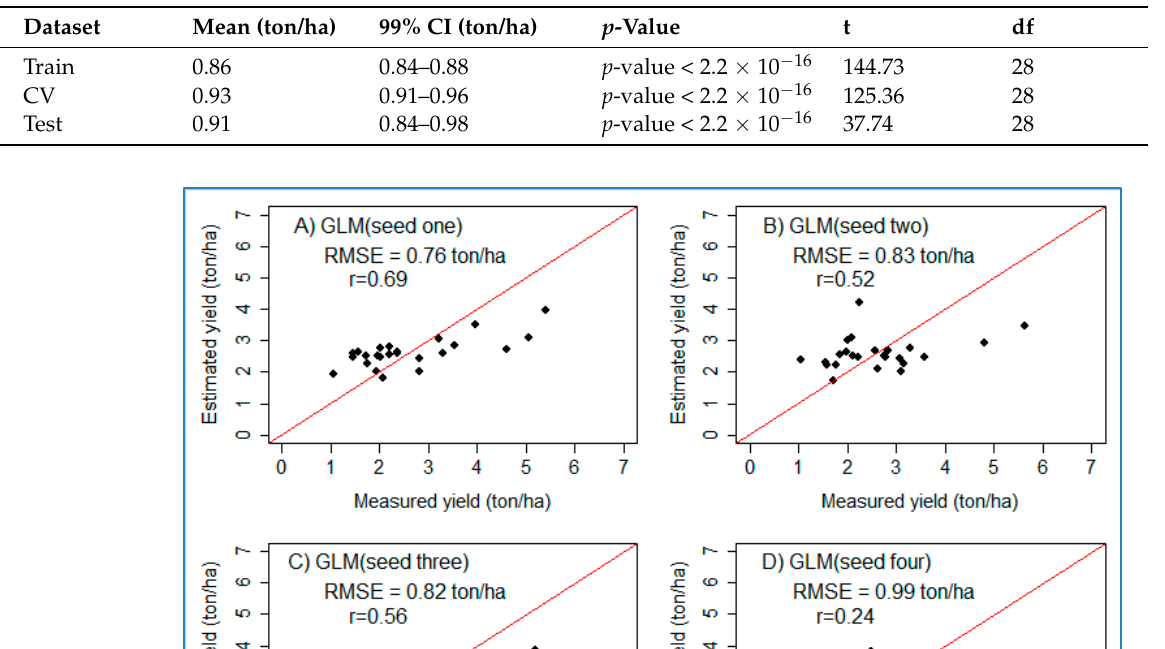
Table 4. Table showing RMSE (ton/ha) CI values of 99% for training, CV, and test datasets.